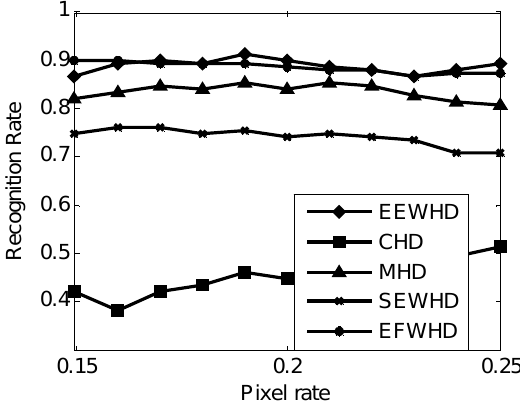
Fig. 6 Comparison of recognition rates using different pixel rate set